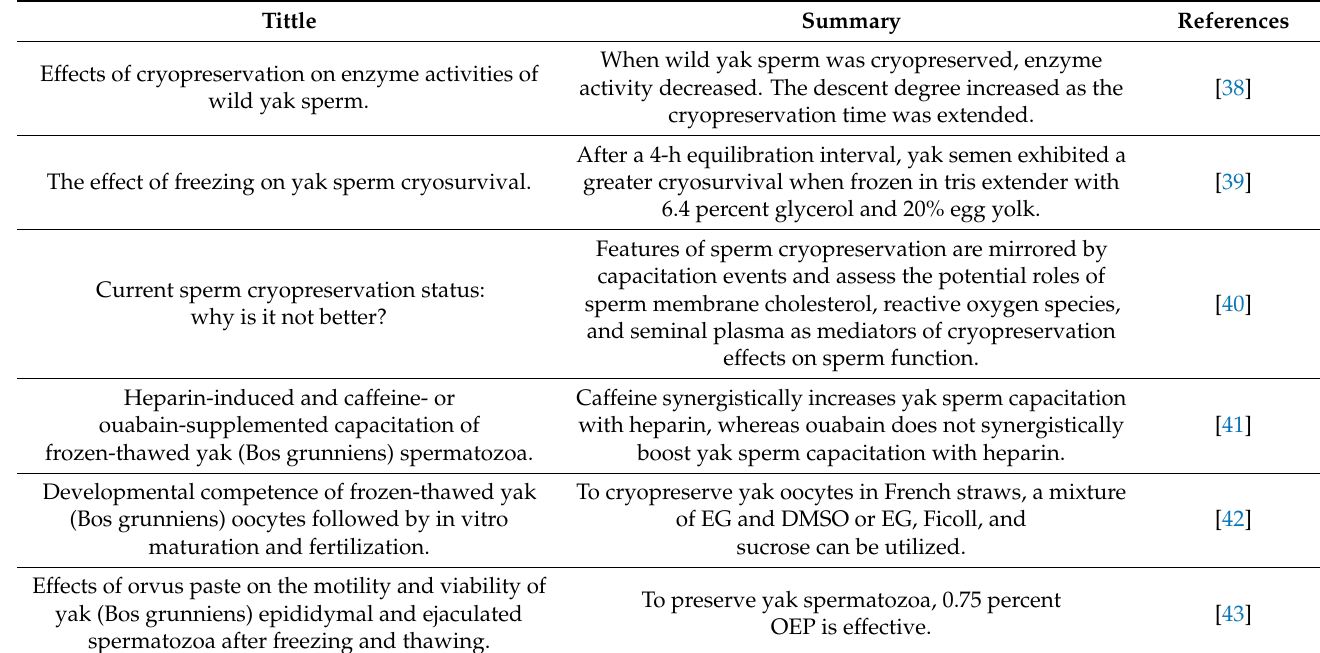
Table 1. Literature survey regarding yak’s gametes cryopreservation.